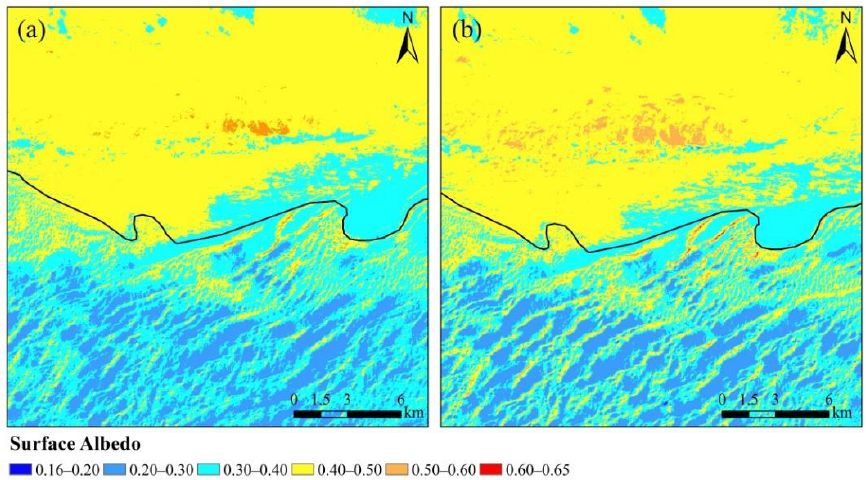
Figure 3. The spatial distribution differences in surface albedo based on STNLFFM ( a ) and C + STNLFFM ( b ). C + STNLFFM ( b